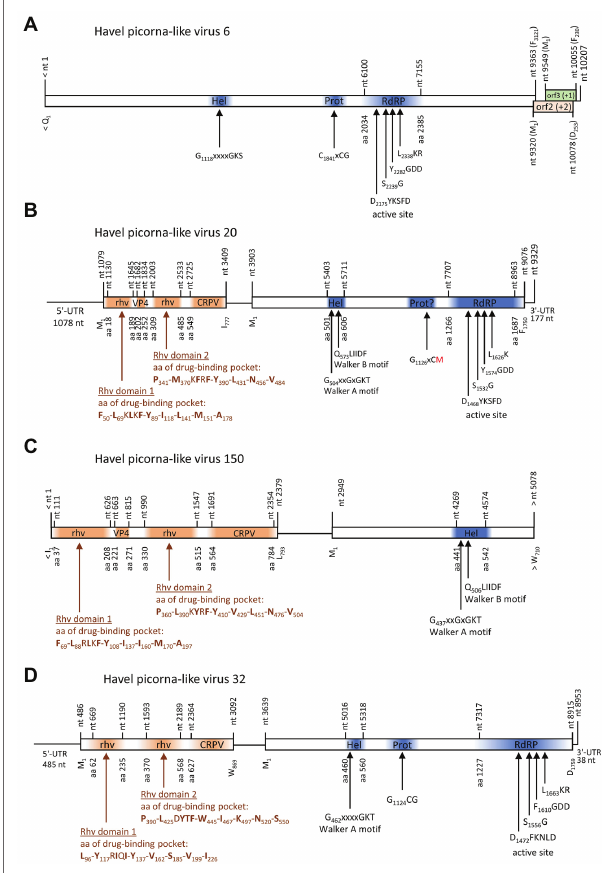
FIGURE 6 | Analysis of solinvivirus-like viruses. (A) Genome organization of Havel picorna-like virus 65 (top) and − 75 (below). Conserved domains and sequence motifs were identified by searching the NCBI Conserved Domain Database (https://www.ncbi.nlm.nih.gov/Structure/cdd/wrpsb.cgi). (B) Phylogenetic analyses of the proteinase/polymerase-encoding gene regions. Sequences of Havel picorna-like virus 65, − 75, and two acknowledged solinviviruses (printed in bold and underlined), 47 unassigned solinvivirus candidates, and 12 reference viruses of the order Picornavirales (printed in brown) were included. The tree was inferred with IQ-Tree 2; optimal substitution model: TVM + F + R6. Presented are GenBank acc. nos. and virus names as well as genus names for the reference viruses. Unassigned viruses are printed in blue. A triangle ( ▲ ) indicates the viruses of the present study. Numbers at nodes indicate bootstrap values obtained after 50,000 ultrafast bootstrap replications. The scale indicates substitutions per site. Hel, helicase; Prot, proteinase; and RdRP, polymerase.